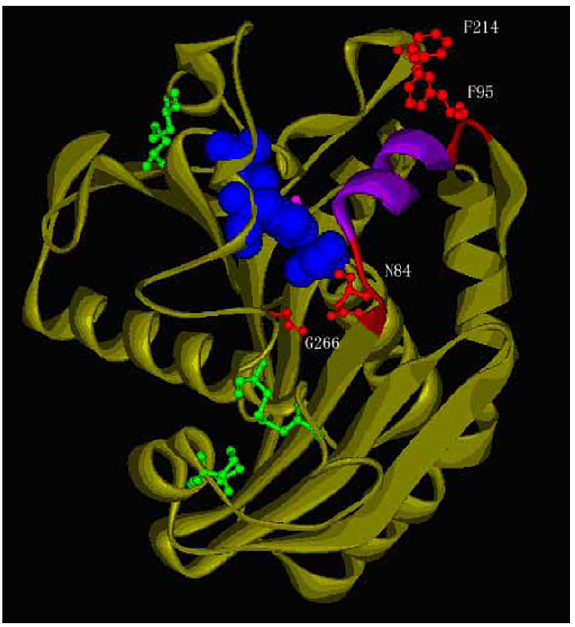
Figure 1. Models of the simulated structure of RCL in a close form. Red, the lid hinge regions ( 82 GTNS 85 and 92 DMVFT 96 ), F214/F95 and N84/G266 as ball and stick; Blue, the catalytic triad of S145-H257- D204; Green, three original disulfide bonds; Pink, the free cysteine C177; Purple, the lid region ( 86 FRSAIT 91 ).